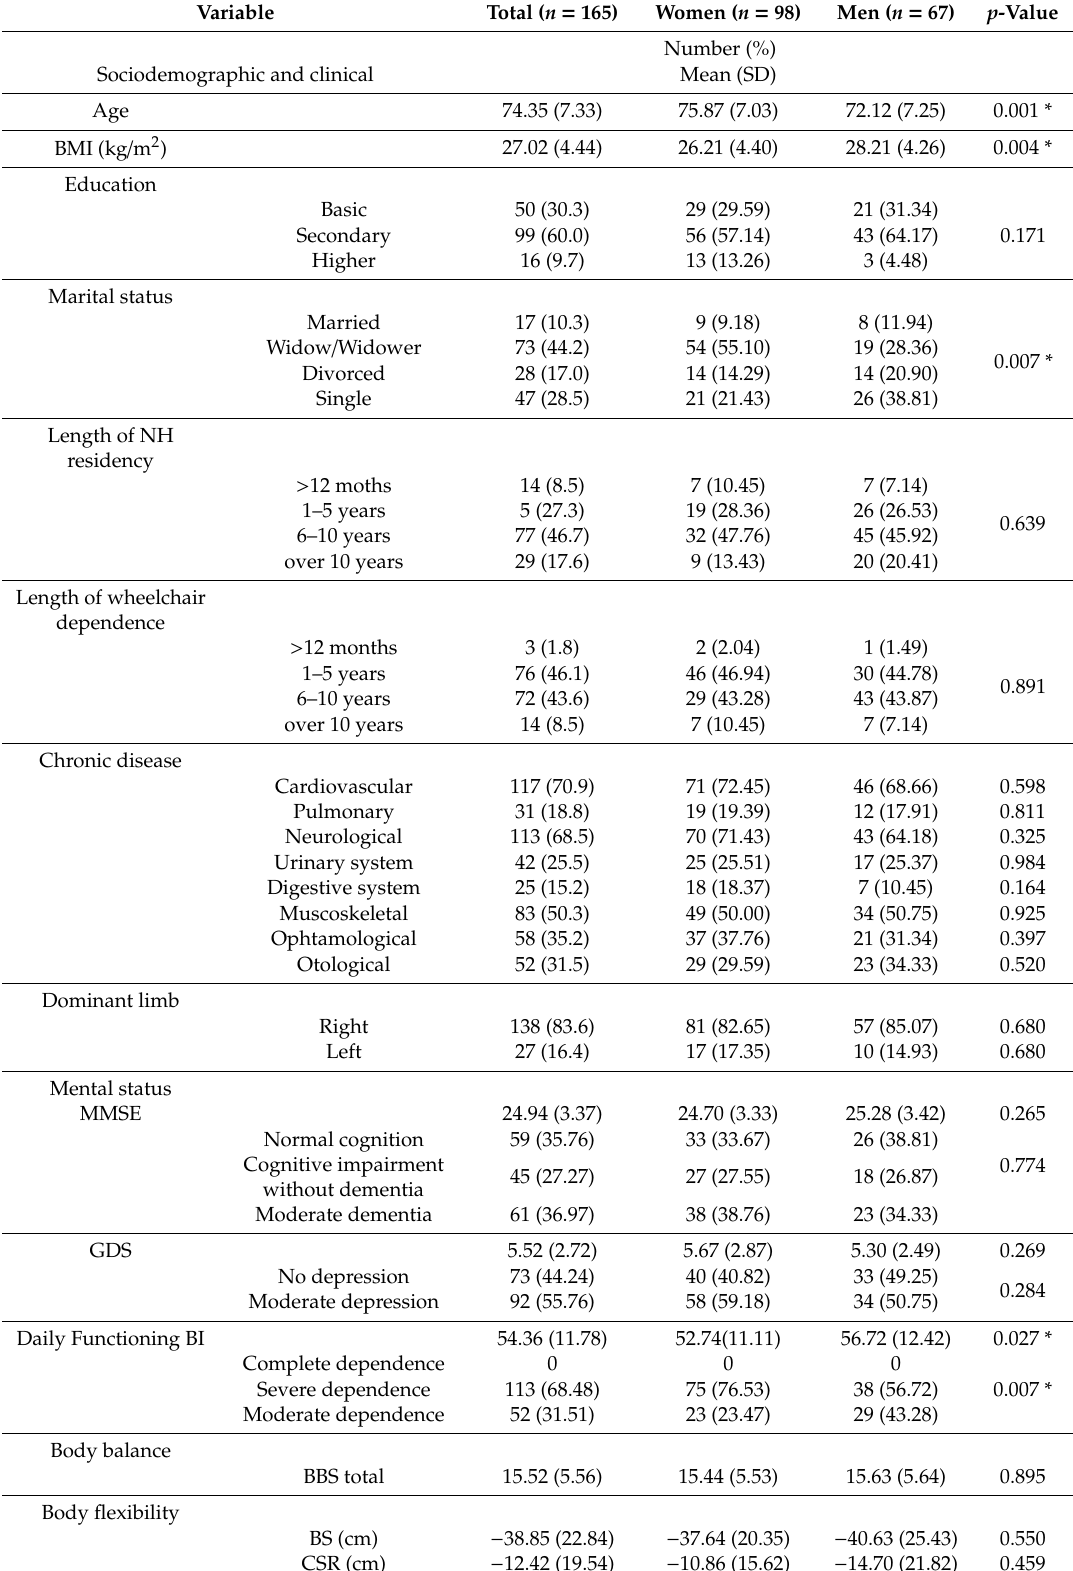
Table 1. Sociodemographic and clinical characteristics of the